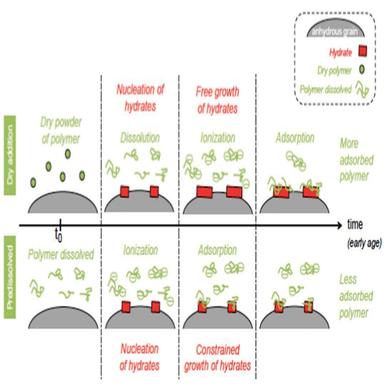
Schematic representation of polysaccharide-cement interaction in relation to the addition method of the VMA. Reproduced from with permission.